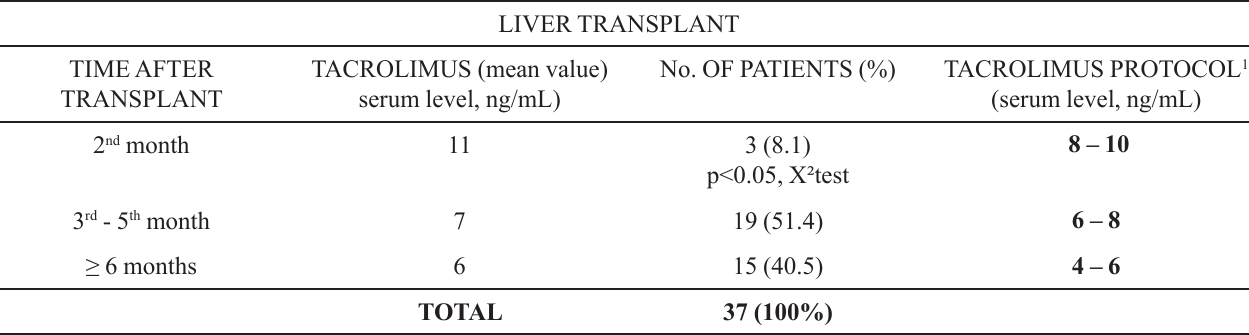
TABLE III - Serum levels of calcineurin inhibitor (Tacrolimus) of liver transplant patients seen by the Pharmaceutical Care Service. April – October/2011, Fortaleza – Ceará